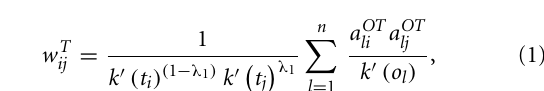
node (1).Thereafter, two separate transfer process are launched to compute the resource in target nodes (2a, 2b) and disease nodes (3a, 3b). Finally, resources are combined to obtain the total quantity in each disease node (4). In (4), the literals are used only for example purposes due to lack of space. They are to be replaced with the values computed in steps (2b) and